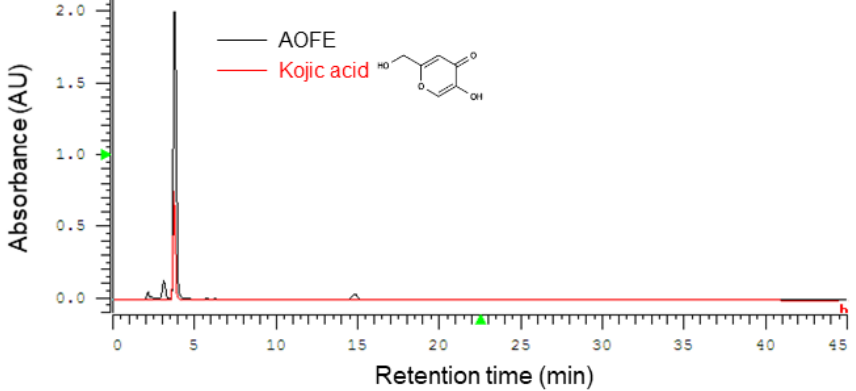
Figure 1. Representative HPLC chromatograms of AOFE and kojic acid standard. Kojic acid was found to be the major component of AOFE.